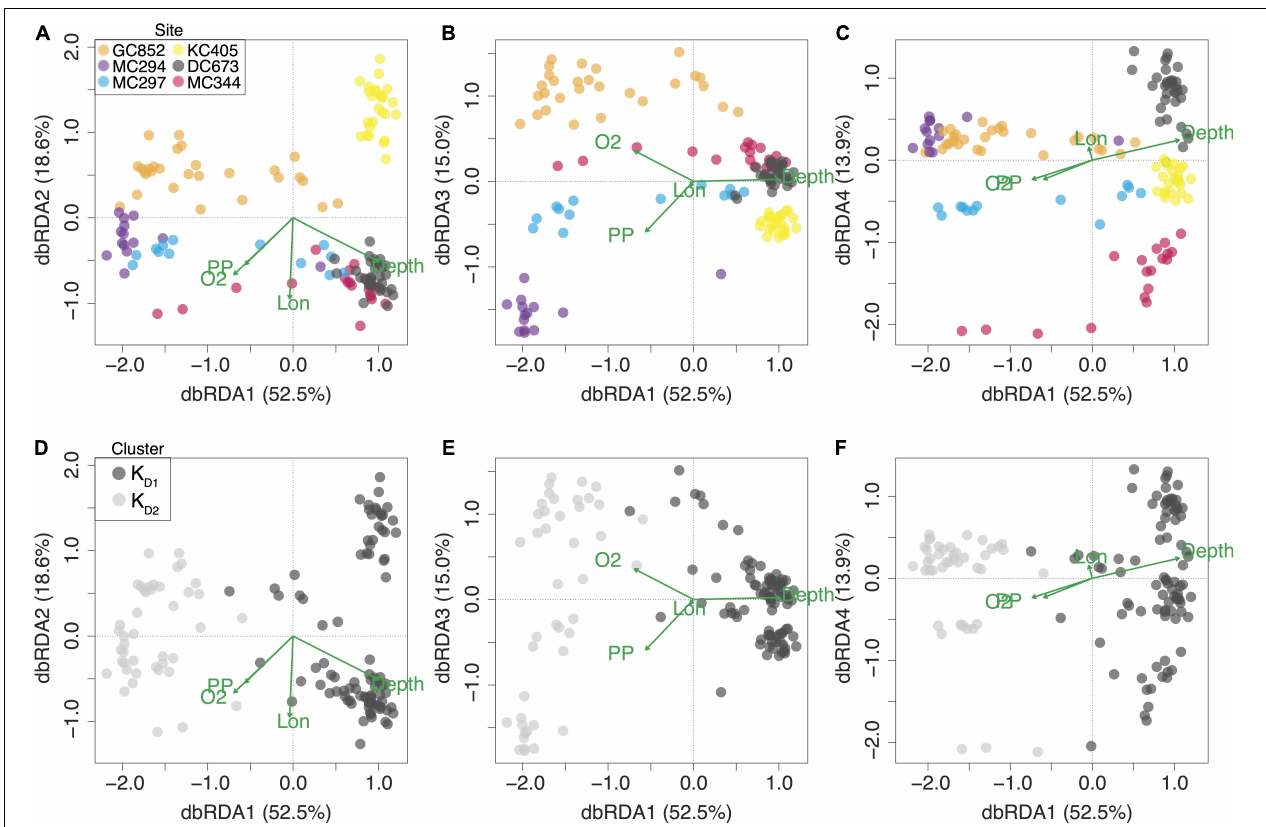
FIGURE 3 | Diplots of distance-based Redundancy Analysis (rbRDA) of environmental (explanatory) and genetic (response) variables. Green vectors represent environmental variables: depth, bottom dissolved oxygen concentration (O 2 ), surface primary productivity (PP), and longitude (Lon). The length of each vector is proportional to its contribution to each axis. rbRDA axes are linear combinations of the environmental variables. Dots represent individual corals. Individuals are color-coded by (A–C) sampling site and (D–F) DAPC cluster